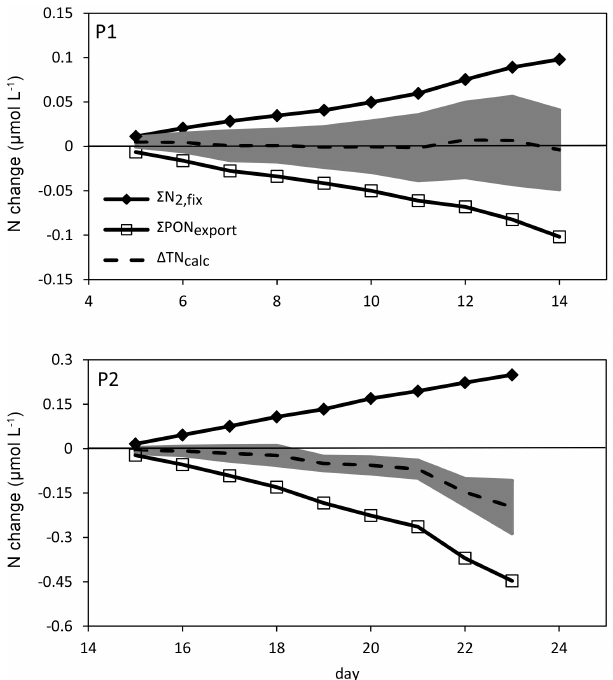
Figure 6. Time-integrated dinitrogen fixation rates ( (cid:54) N 2,fix ) and particulate organic nitrogen exported ( (cid:54) PON export ) during P1 (dominance of diatom–diazotroph associations) and P2 (dominance of unicellular N 2 -fixing cyanobacteria group C) in the mesocosms together with the calculated change in Total N content ( (cid:49) TN calc ) defined as the difference between (cid:54) N 2,fix and (cid:54) PON export . The shaded areas represent the uncertainty associated with the (cid:49) TN calc